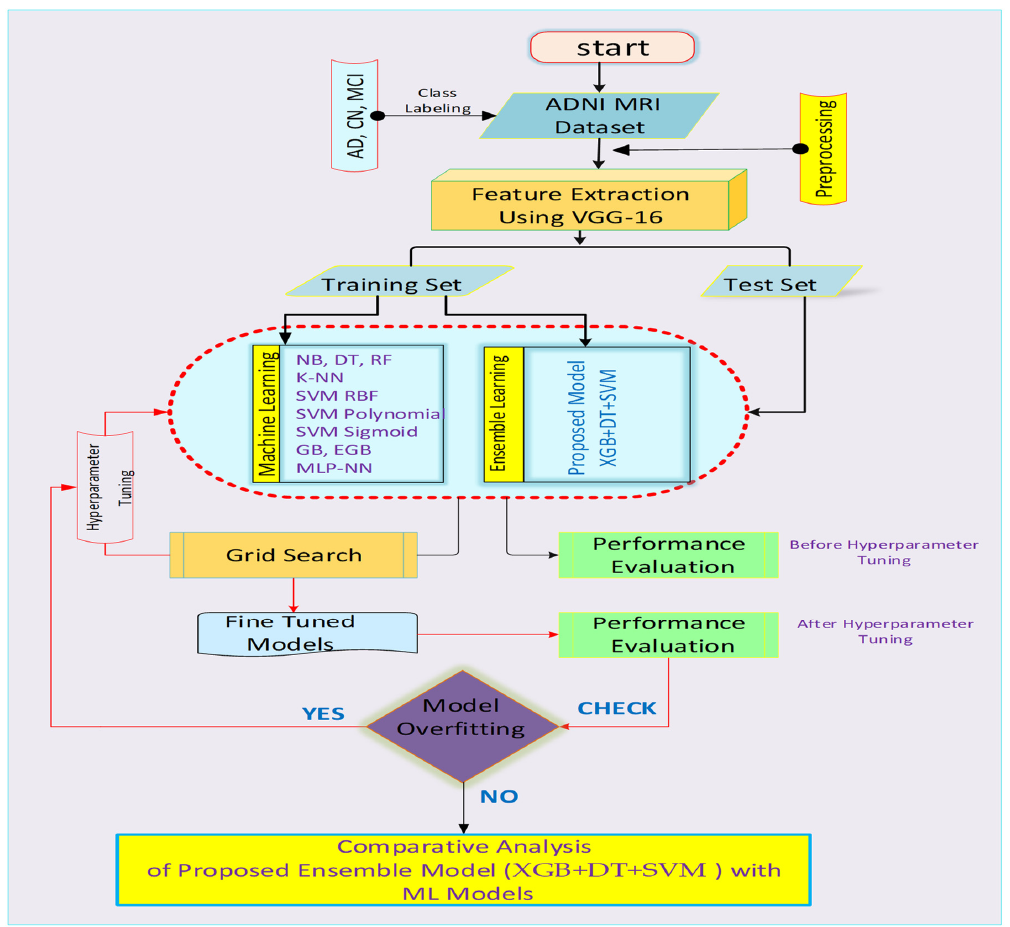
Figure 4. The flow chart depicts the flow of the